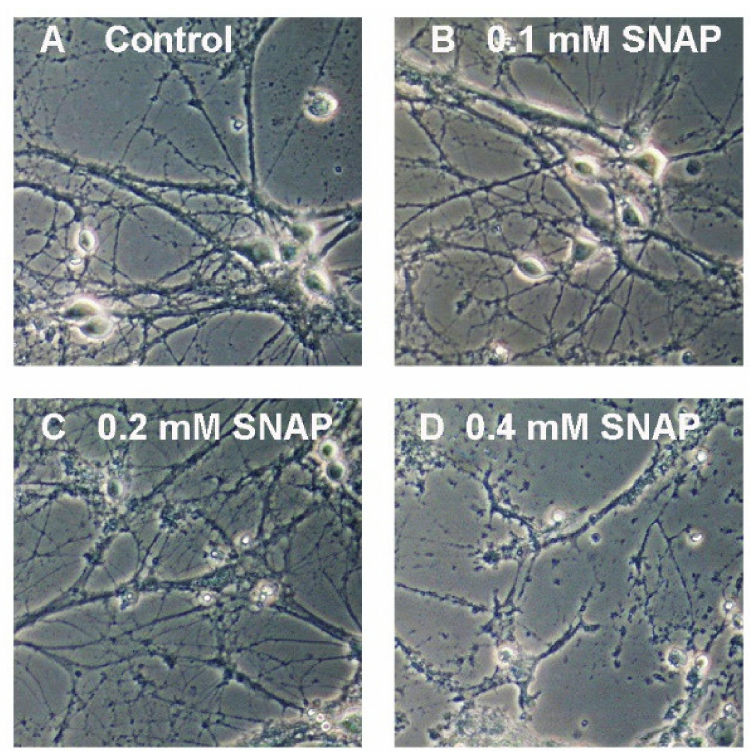
Figure 4. The impact of neurotoxic factors on primary neurons morphology or the N -acetylaspartate network related to neuronal energy pathways. The impact of SNAP: ( a ) control; ( b ) 0.1 mM SNAP; ( c ) 0.2 mM SNAP (in further experiments, used as basic SNAP concentration); ( d ) 0.4 mM